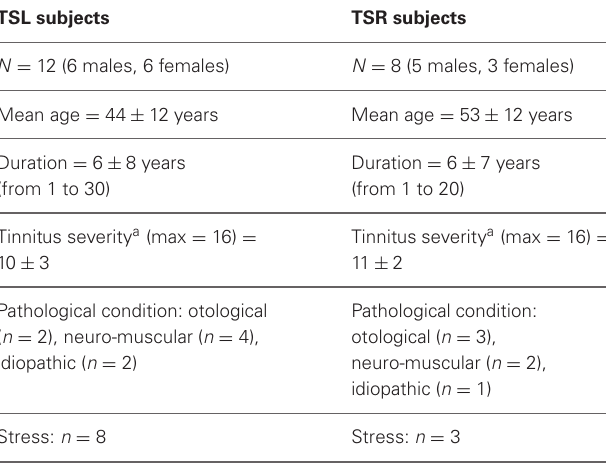
Table 1 | Clinical characteristics of tinnitus